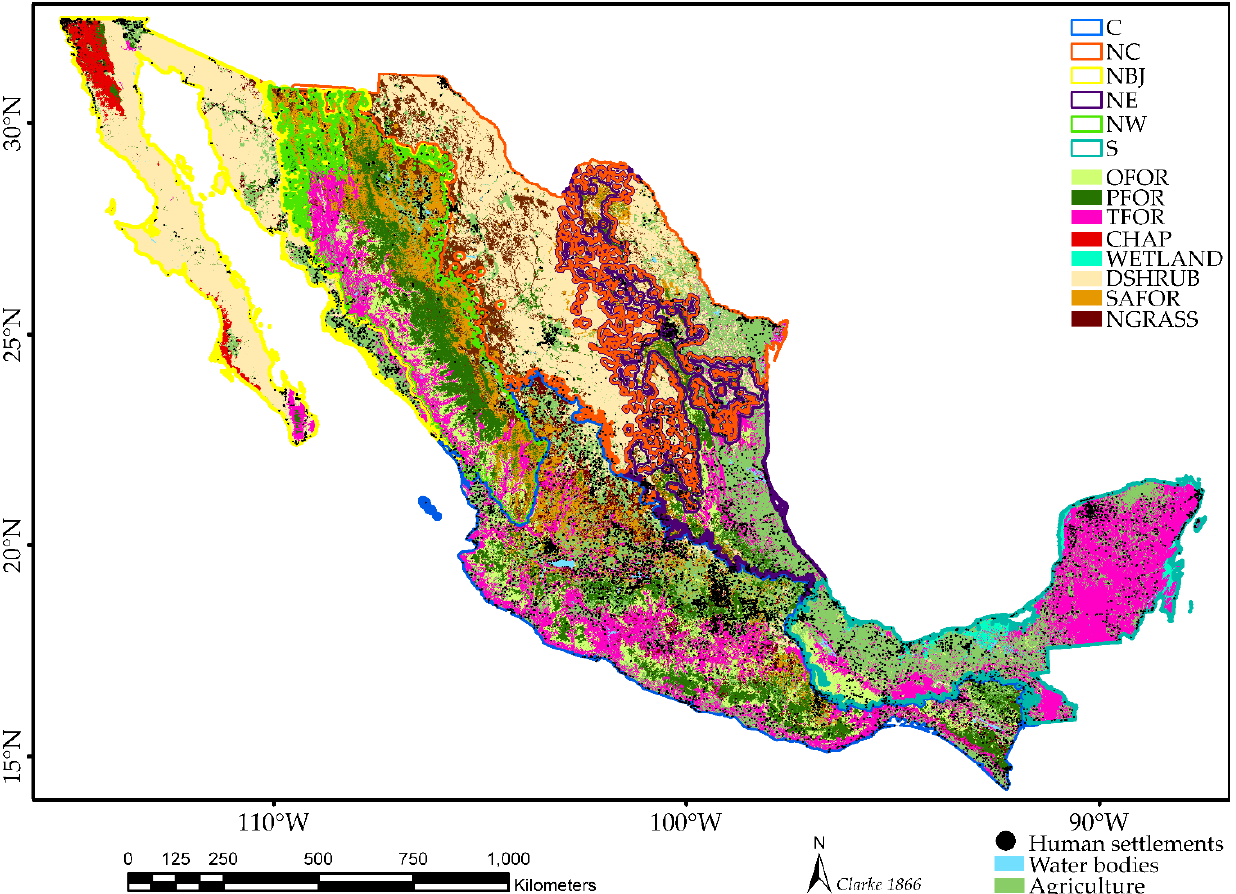
Figure 1. Map of fuelbed types and regions of study, where C: central; NC: north central; NBJ: North Baja California; NE: northeast; NW: northwest; S: south region. OFOR: oak forests; PFOR: pine forests; TFOR: tropical forests; CHAP: chaparral forests; WETLAND: wetlands; DSHRUB: desert shrubland forest; SAFOR: semiarid forests; NGRASS: natural grasslands. Human settlements are shown in black, water bodies in blue, and agriculture in green, based on the Land-Use Map Series VI (INEGI, 2014) [25].